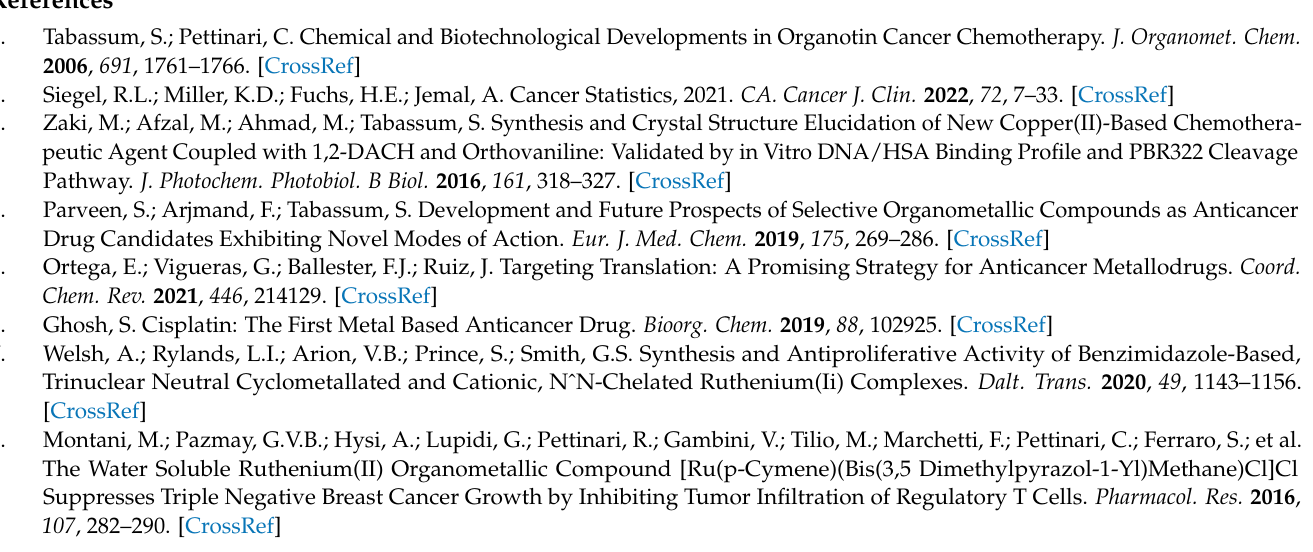
Table S3: in vitro antitumor activity